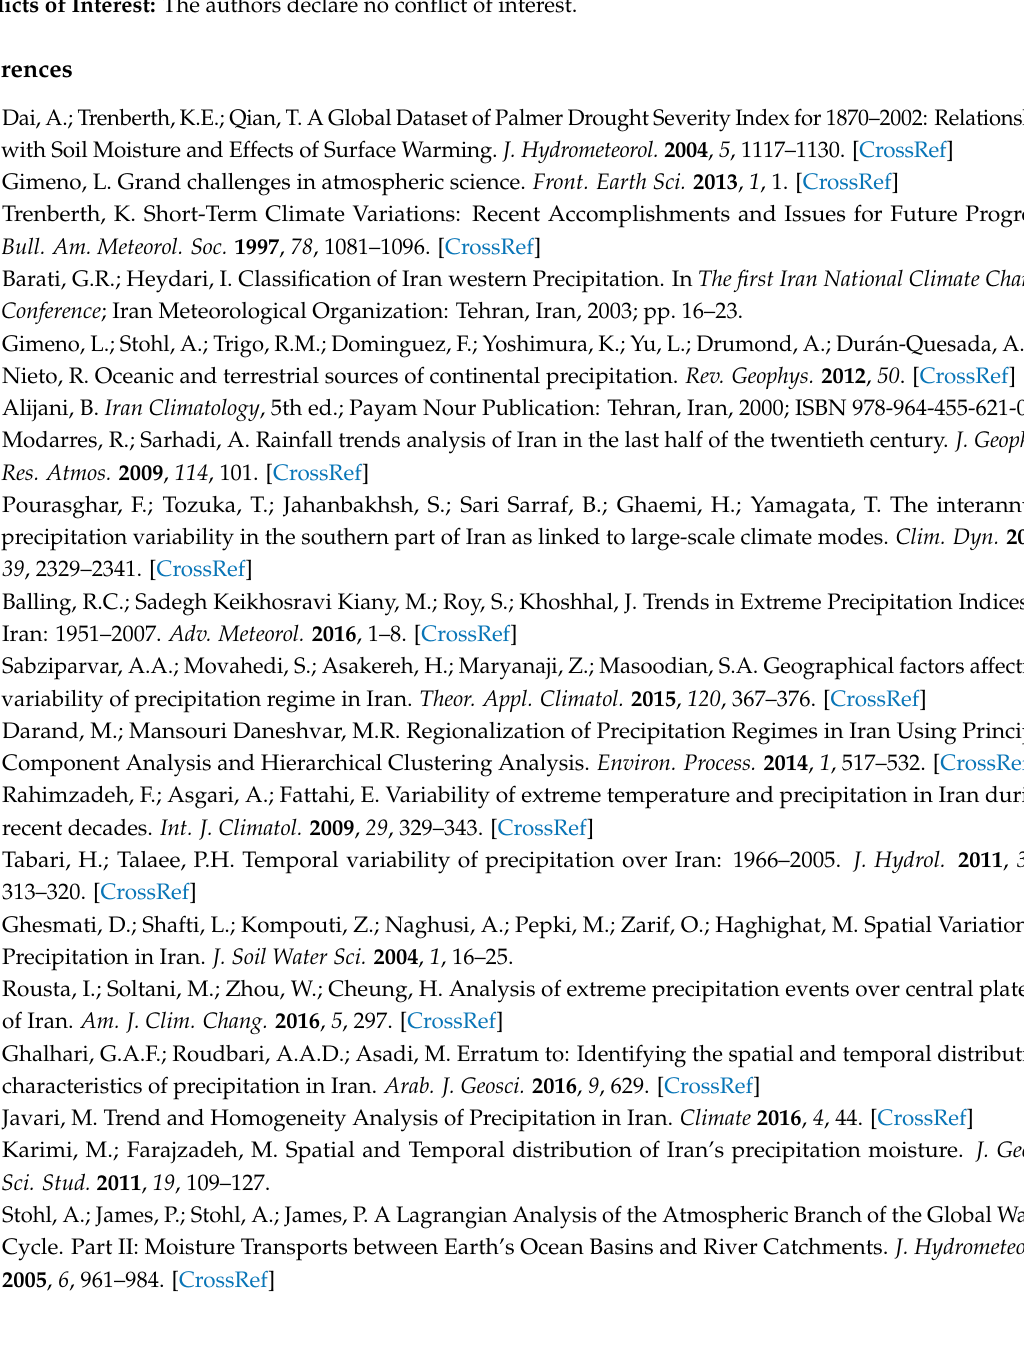
Table S1: The continental and oceanic (E-P) values, precipitation amounts, and 1-month, 6-month, and 12-month SPI values calculated for 15 studied locations. Shiraz (A), Mashhad (B), Shahrood (C), Rafsanjan (D), Hashtgerd (E), Marivan (F), Isfahan (G), Chabahar (H), Tabriz (I), Tabas (J), Ahvaz (K), Bandar Abbas (L), Zabol (M), and Khoram Abad (N); Table S2: Regression model of the (E-P) > 0 values of continental and oceanic moisture sources with 1-month, 6-month, and 12-month SPI values; Figure S1: The correlation between oceanic and continental (E-P) > 0 values vs. precipitation amount in Iran during dry and wet seasons; Spreadsheet S1: The full data set of average precipitation amount, and 1-month, 6-month, and 12-month SPI values calculated for Iran, Shiraz, and Mashhad locations for dry and wet seasons during 1981 to